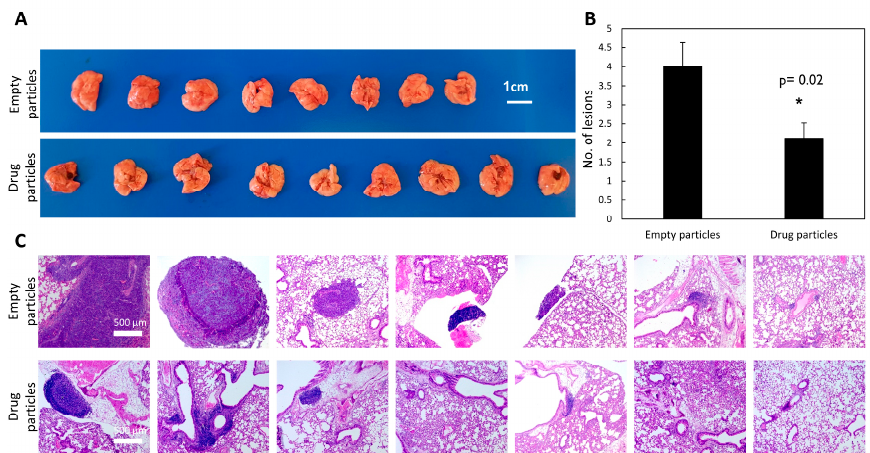
Figure 4. The effect of carbenoxolone-loaded particles in tail vein injection (40 mg/kg, single administration). ( A ) Tail vein systemic injections in C57BL/6 mice. Mice were pre-treated intravenously (IV) with drug-loaded particles (empty particles as control). On the 5th day, all mice Figure 4. The e ff ect of carbenoxolone-loaded particles in tail vein injection (40 mg / kg, single administration). ( A ) Tail vein systemic injections in C57BL / 6 mice. Mice were pre-treated